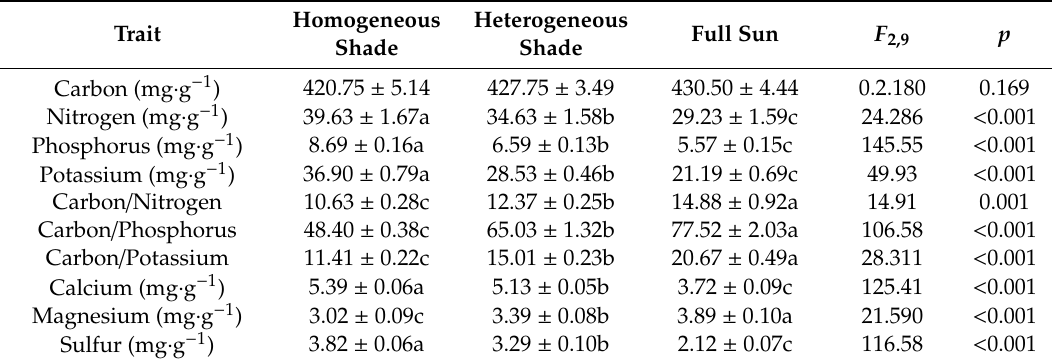
Table 3. Elemental concentrations and stoichiometry of the Zea mays leaves following plant growth in homogeneous 62% sunlight exclusion under a shade screen, heterogeneous 62% sunlight exclusion under a slat-house, or full sunlight. Mean ± SE, n = 4.